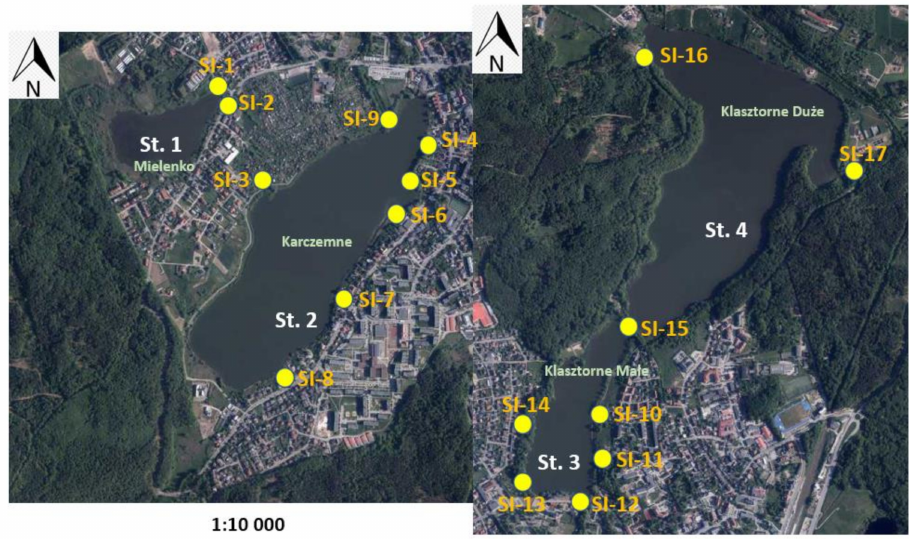
Figure 2. Location of sample